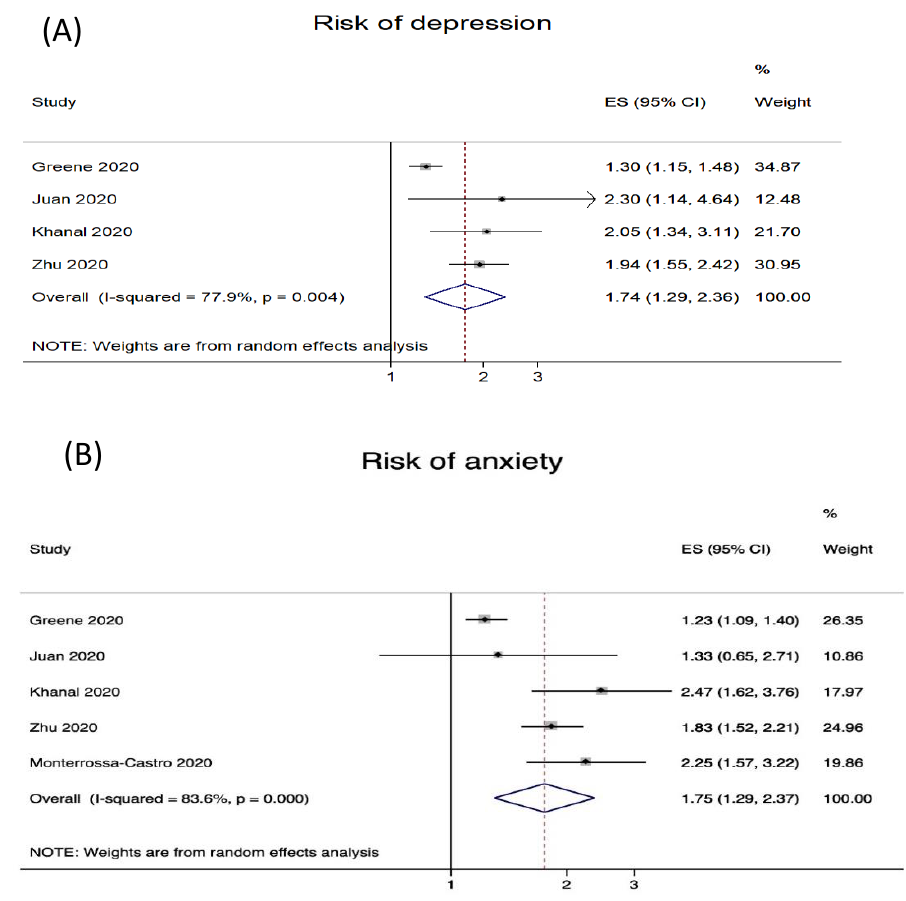
Figure 2. Risk of depression ( A ) and anxiety ( B ) in association with work-related stigmatization from COVID-19 exposure.